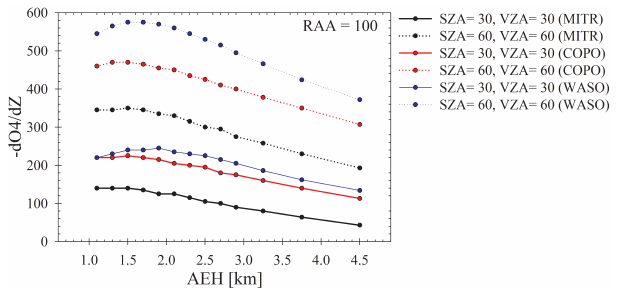
Figure 5. The AEH sensitivity to O4I ( − dO 4 /d Z ) with changing observation geometries at